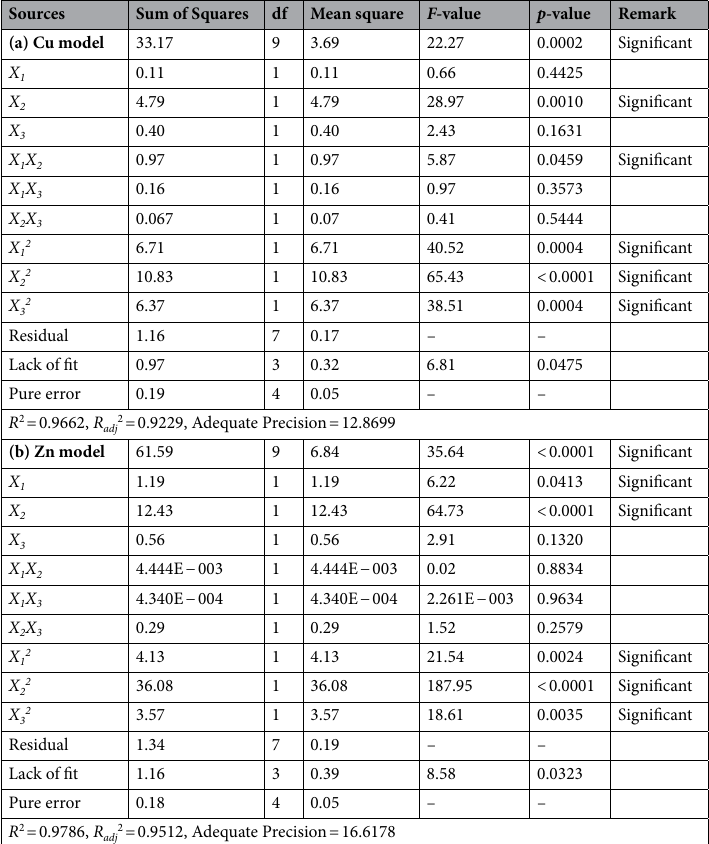
Table 3. ANOVA results for response surface quadratic models for Cu 2+ and Zn 2+ adsorption efficiency.